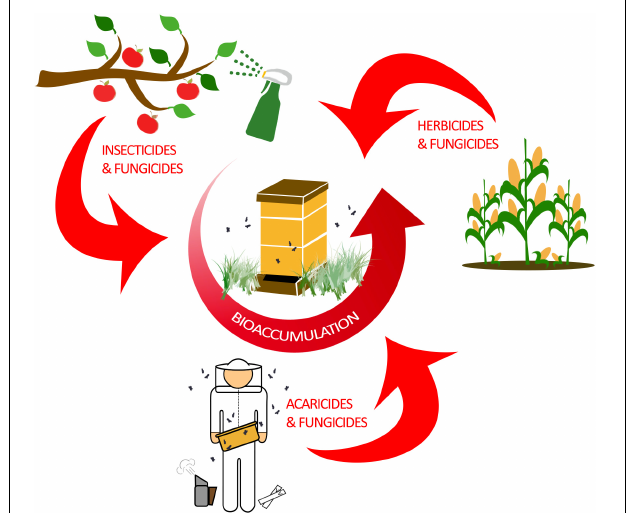
FIGURE 1 | Bioaccumulation of pesticides in a honey bee colony. Honey bees are exposed to a wide variety of pesticides through agricultural practices and modern beekeeping. Typically, farming and other agricultural practices are responsible for exposing honey bees to insecticides, herbicides, and fungicides. As honey bees forage for nectar and pollen, they are incidentally exposed to pesticides which accumulate in the hive by physically transferring the contaminated food sources to unexposed bees. However, honey bees can also be intentionally exposed to acaricides and fungicides by beekeepers in efforts to control mite burden and fungal diseases in the hive. Ultimately, pesticide bioaccumulation in the hive has the potential to negatively impact all honey bee